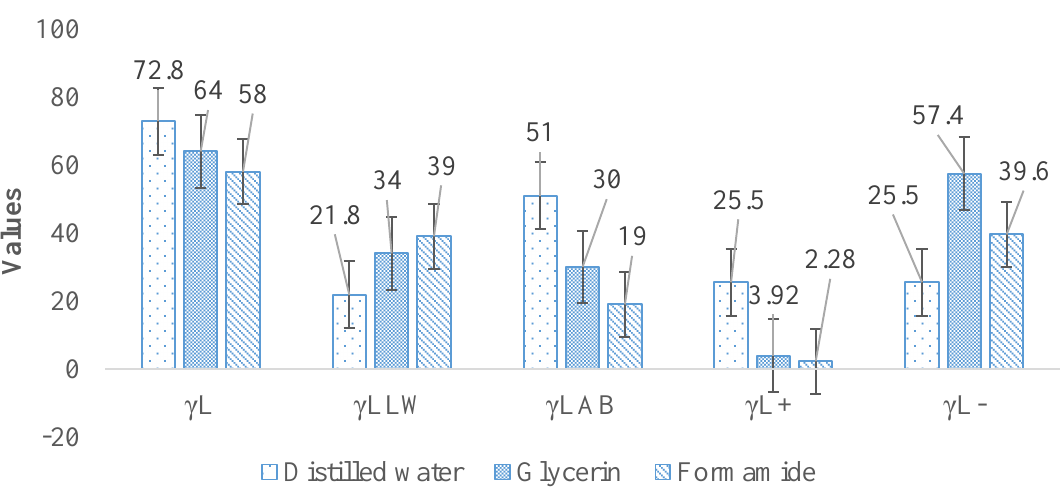
Figure 4. The Surface Free Energy Components of Test Liquids (mJ/m 2 ) (Note: γ L—the surface free energy of test liquid; γ L LW —the nonpolar part of the surface free energy of test liquid; γ L AB —the polar part of the surface free energy of test liquid; γ L + —the acidic effect part of the surface free energy of test liquid; γ L − —the basic effect part of the surface free energy of test liquid.).